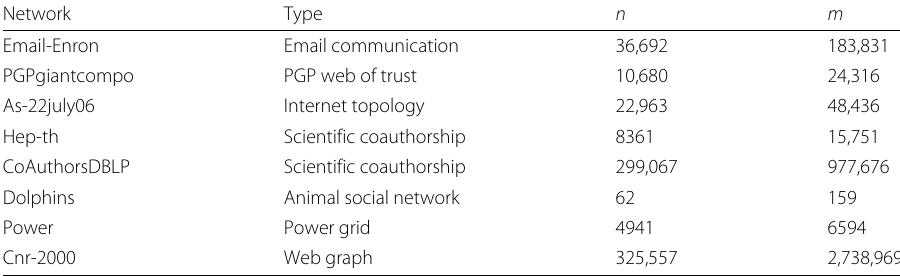
Table 2 Additional networks used